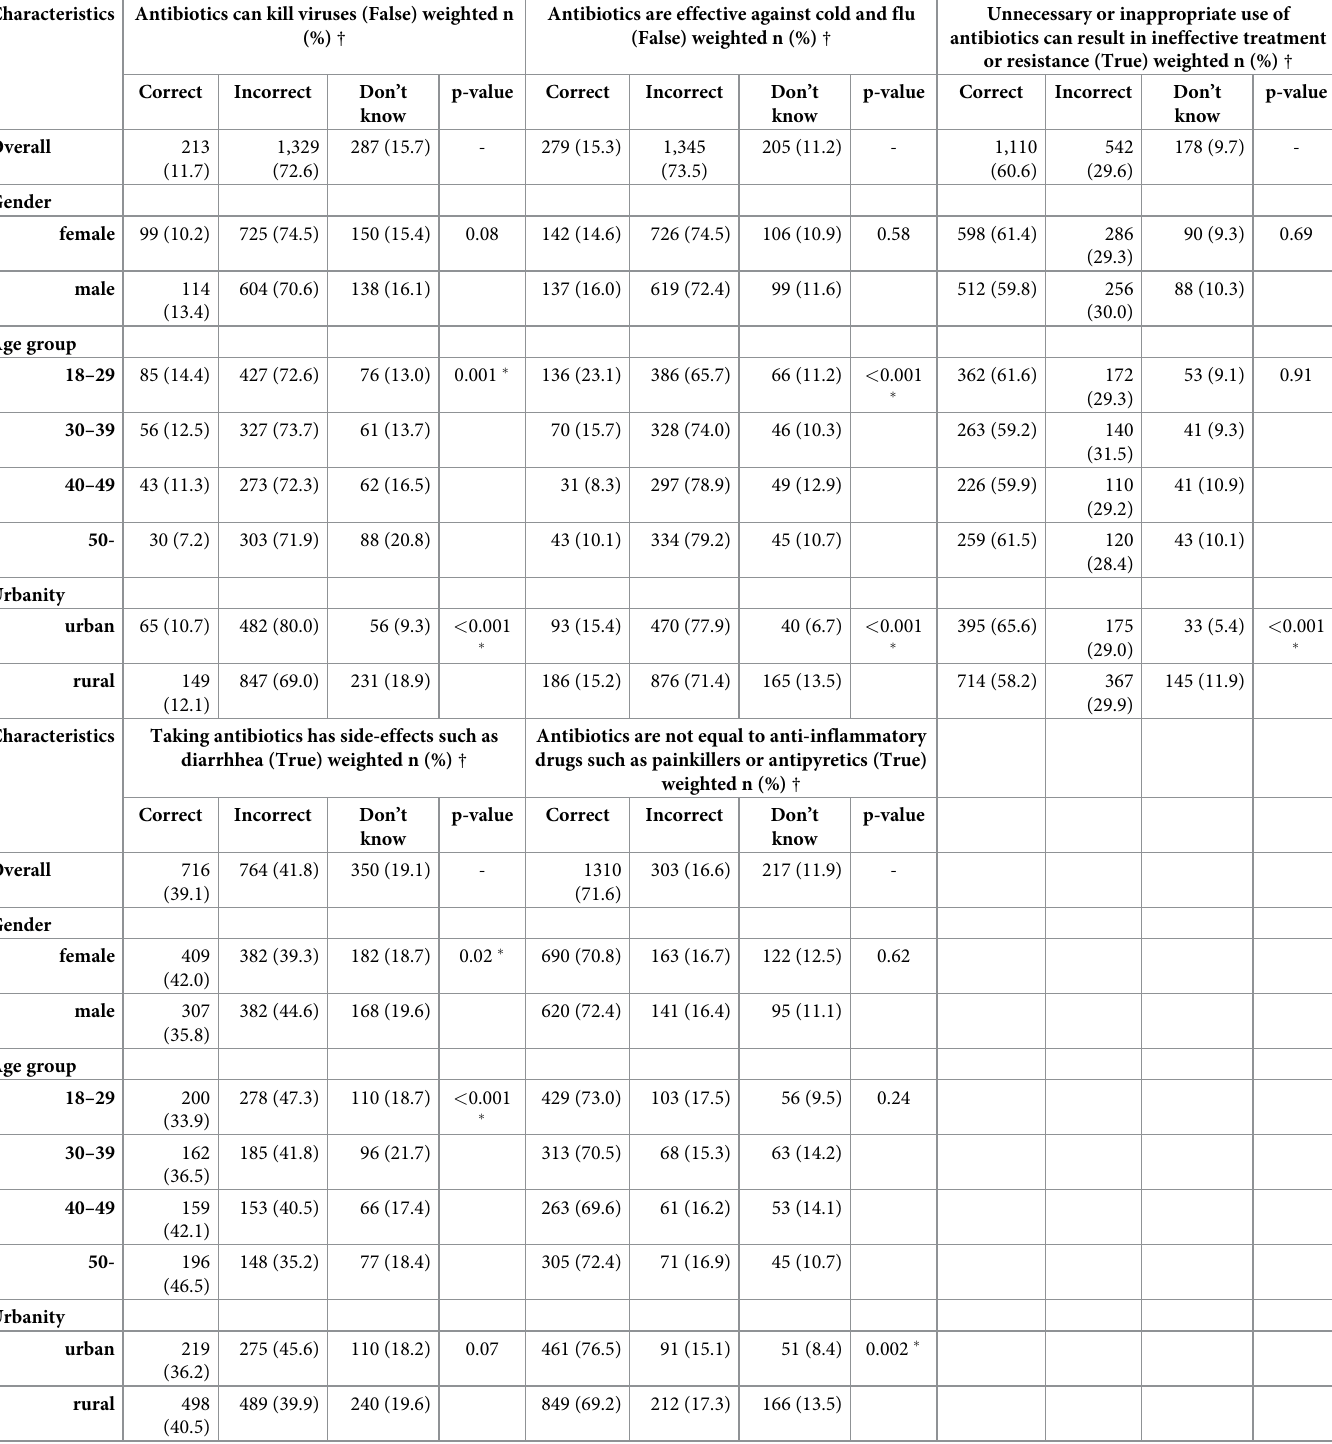
Table 3. Five true/false questions used to assess the survey participants’ knowledge of antibiotics (N = 1,830). Characteristics Antibiotics can kill viruses (False) weighted n (%) †